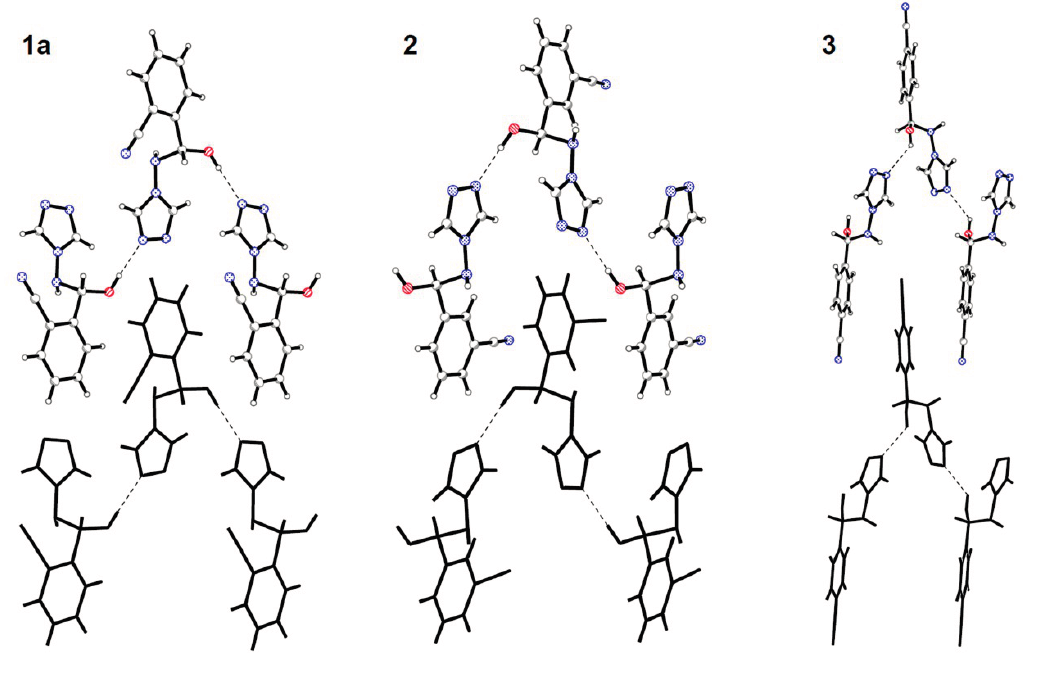
Figure 5. Zipper-like motives in the crystal structures of stretched hemiaminals 1a , 2 and 3